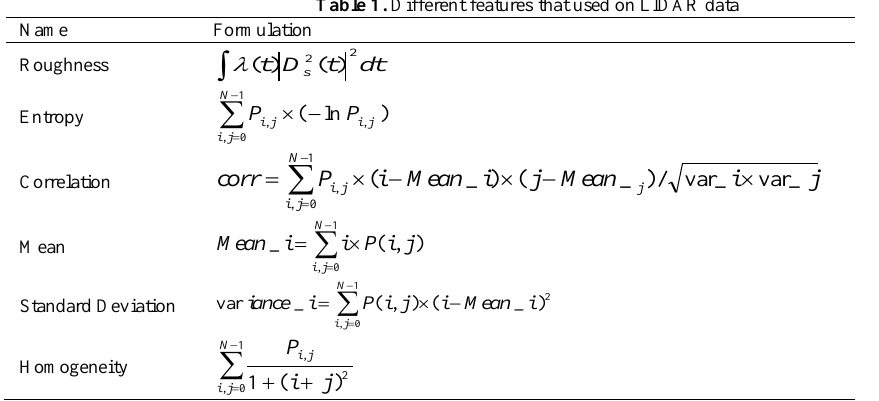
Table 1. Different features that used on LIDAR data